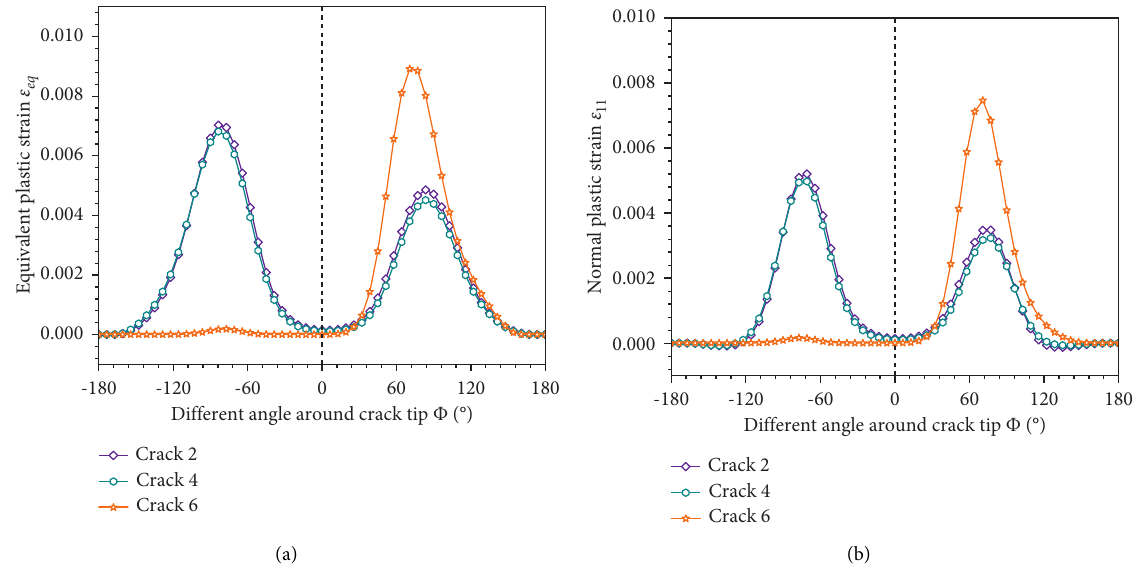
Figure 11: The strain curve at the crack tip of the interface. (a) Equivalent plastic strain and (b) normal plastic strain.